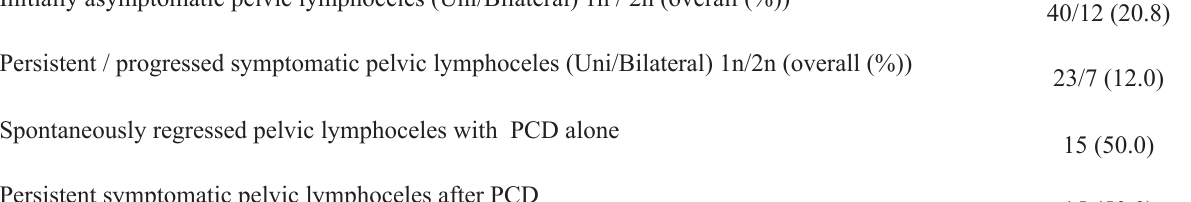
Table 1 – Pelvic lymphoceles after pelvic lymphadenectomy and RRP. Initially asymptomatic pelvic lymphoceles (Uni/Bilateral) 1n / 2n (overall